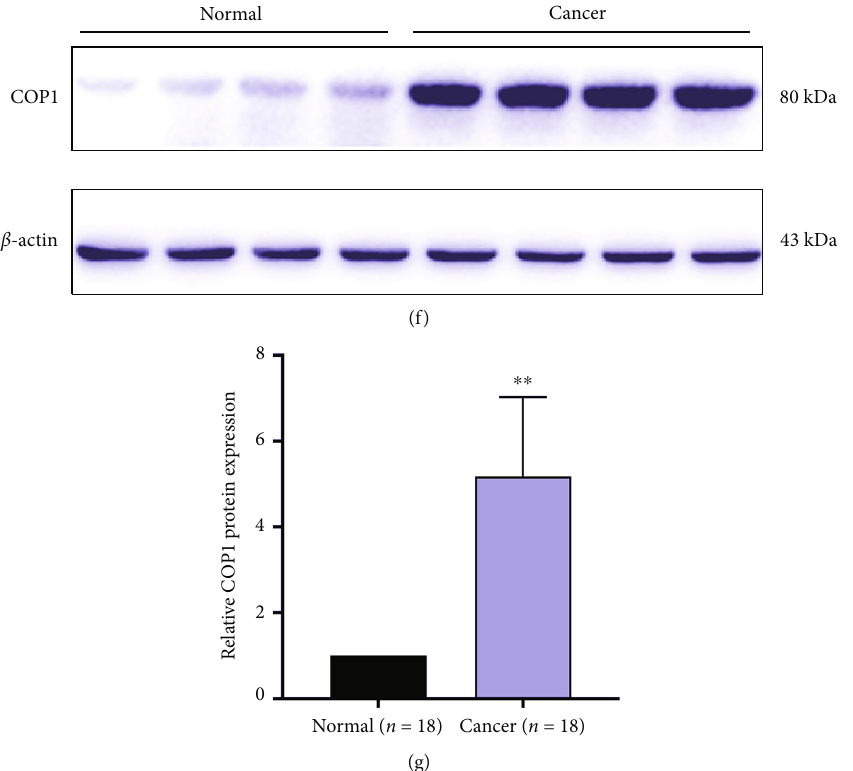
Figure 1: COP1 was upregulated in GC tissues. (a and b) Analysis of GEO and TCGA databases revealed over-expression of COP1 in GC tissues; (c) real-time quantitative PCR demonstrated the upregulation of mRNA expression of COP1 in GC; (d, e, f, and g) immunohistochemical staining and Western blotting analysis showed signi fi cant upregulation of the protein expression of COP1 in GC; Bar=200 μ m. * P < 0 : 05 , ** P < 0 : 01 , *** P < 0 : 001